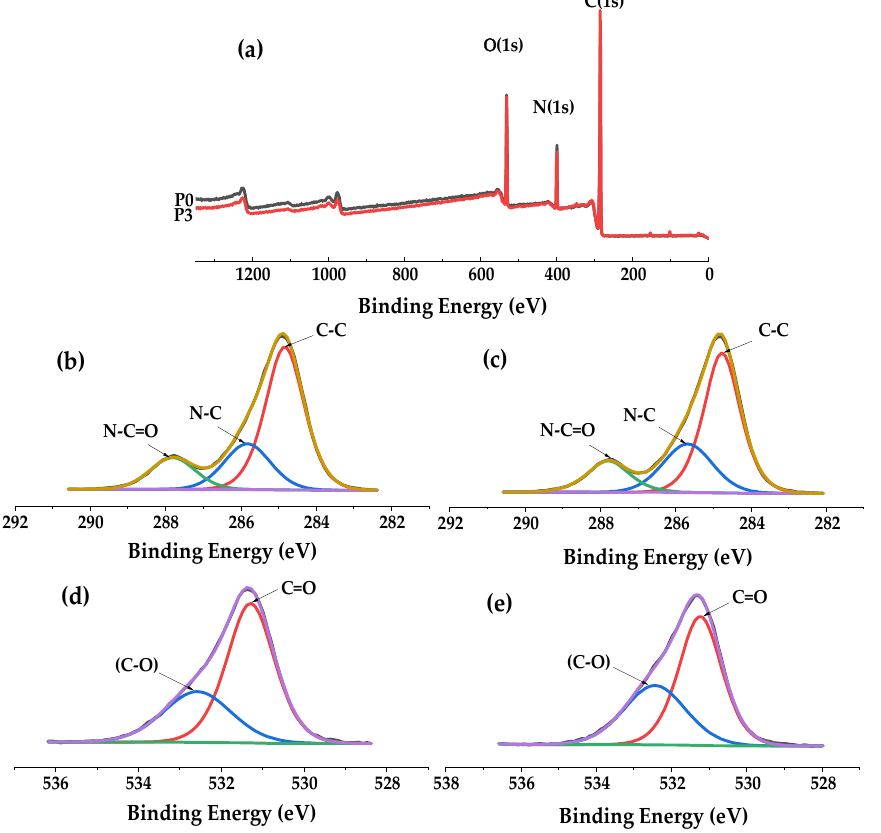
Figure 7. ( a ) XPS full-scan spectra of P0 and P3 membrane; ( b ) and ( c ) C1s spectra of P0 membrane and P3 membrane; ( d ) and ( e ) O1s spectra of P0 and P3 membrane. Table 2. Elemental composition by atomic percent of pure PA66 membrane and PA66-GO membrane.